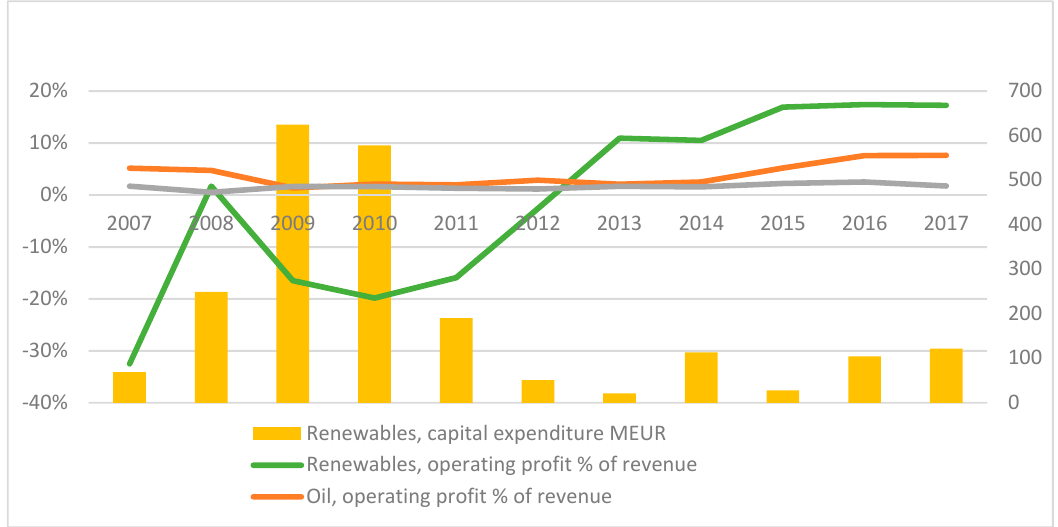
Figure 3. Neste production volume and revenue. Source: [16].